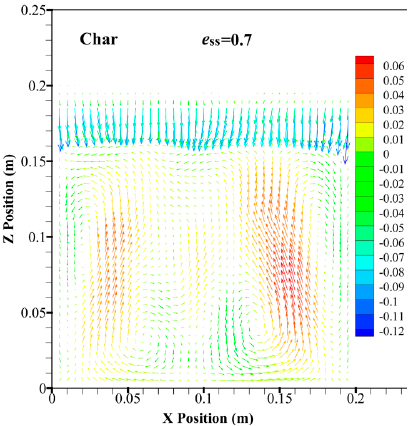
Figure 7. Time-averaged particle velocity distribution of the flotsam for e ss = 0.7 (the color legend represents the axial velocity of the particles).